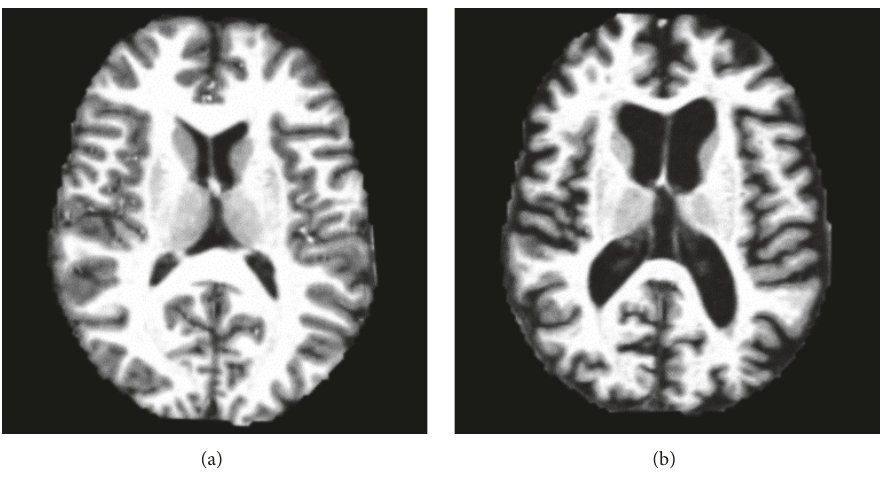
Figure 1: Slice examples between (a) a nonalcoholic brain and (b) an alcoholic